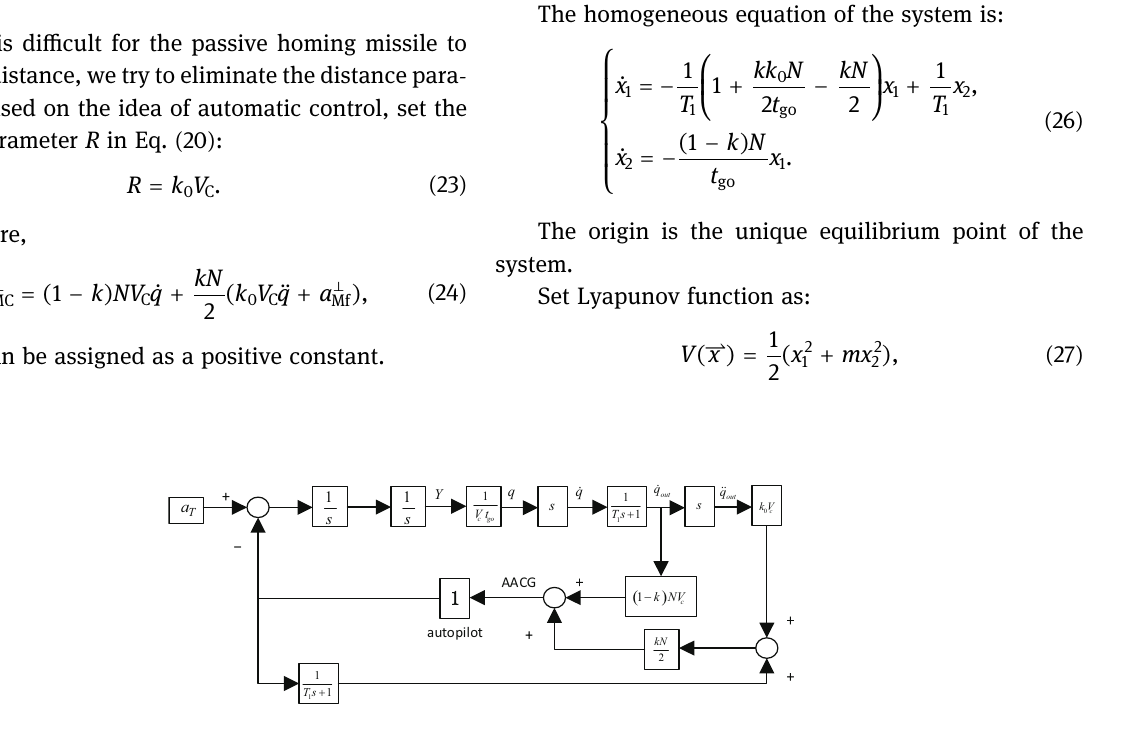
Figure 2: First - order linearized AACG guidance system